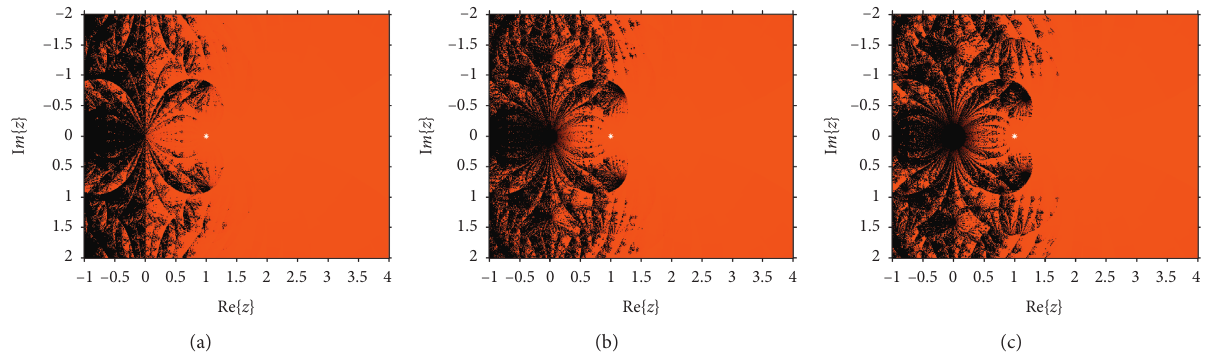
Figure 11: Basins of attraction of (a) BM1, (b) AM2, and (c) ZM3 for g